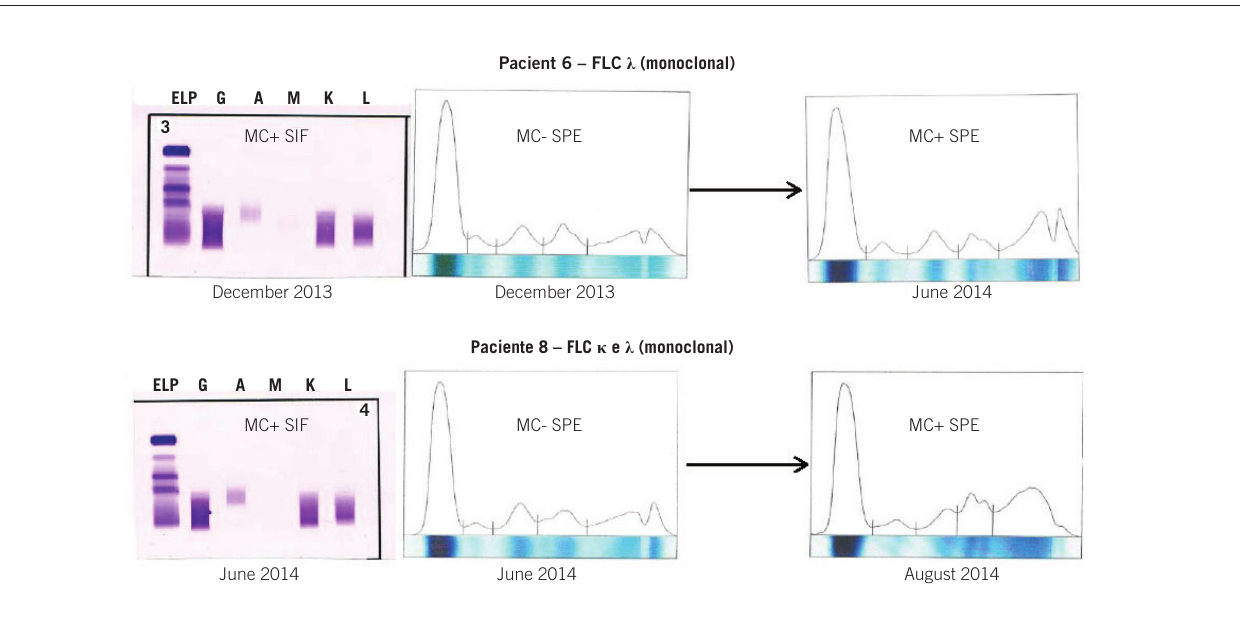
figuRE 4 − Comparative images between SIF and SPE in serum proteins analysis to detect MC in patients 6 and 8, with the same FLC component, at different moments MC+ and MC- indicate the presence and absence of mono/biclonal components,